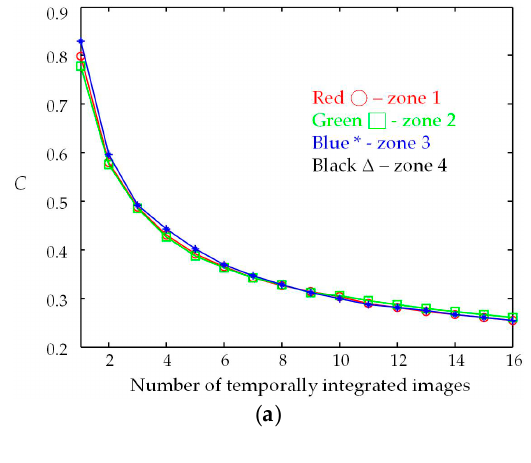
Figure 8. Cont. Figure 8.